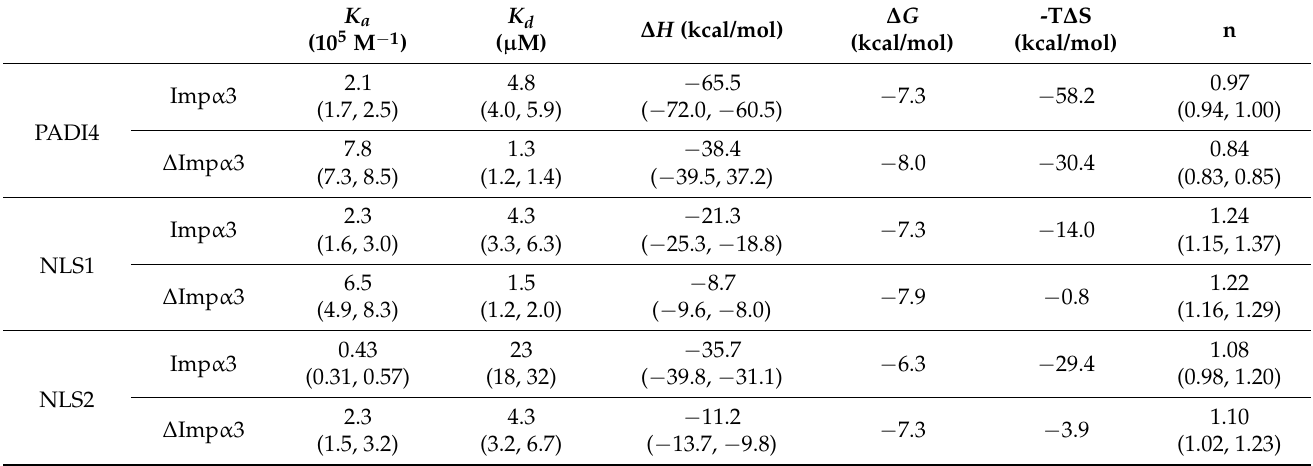
∆ Imp α Table 1. Thermodynamic parameters of binding of PADI4 to the different macromolecules a .